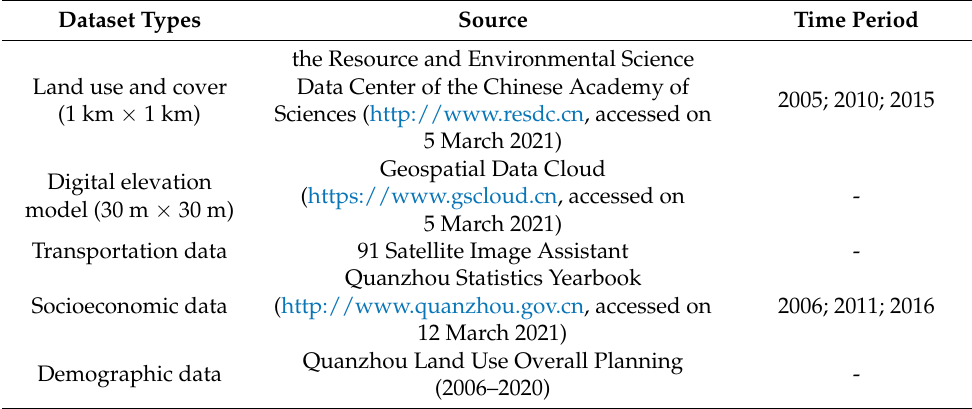
Table 1. Summary of the data sets used in this study.